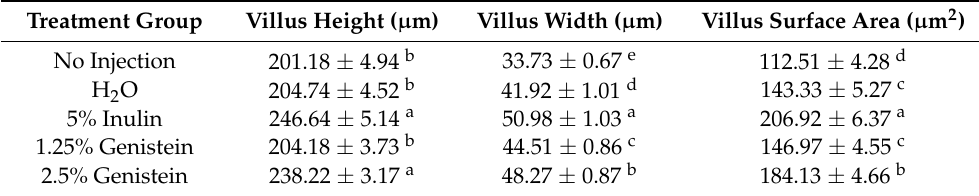
Table 4. Effects of genistein intraamniotic administration on duodenal small intestinal villus 1 .